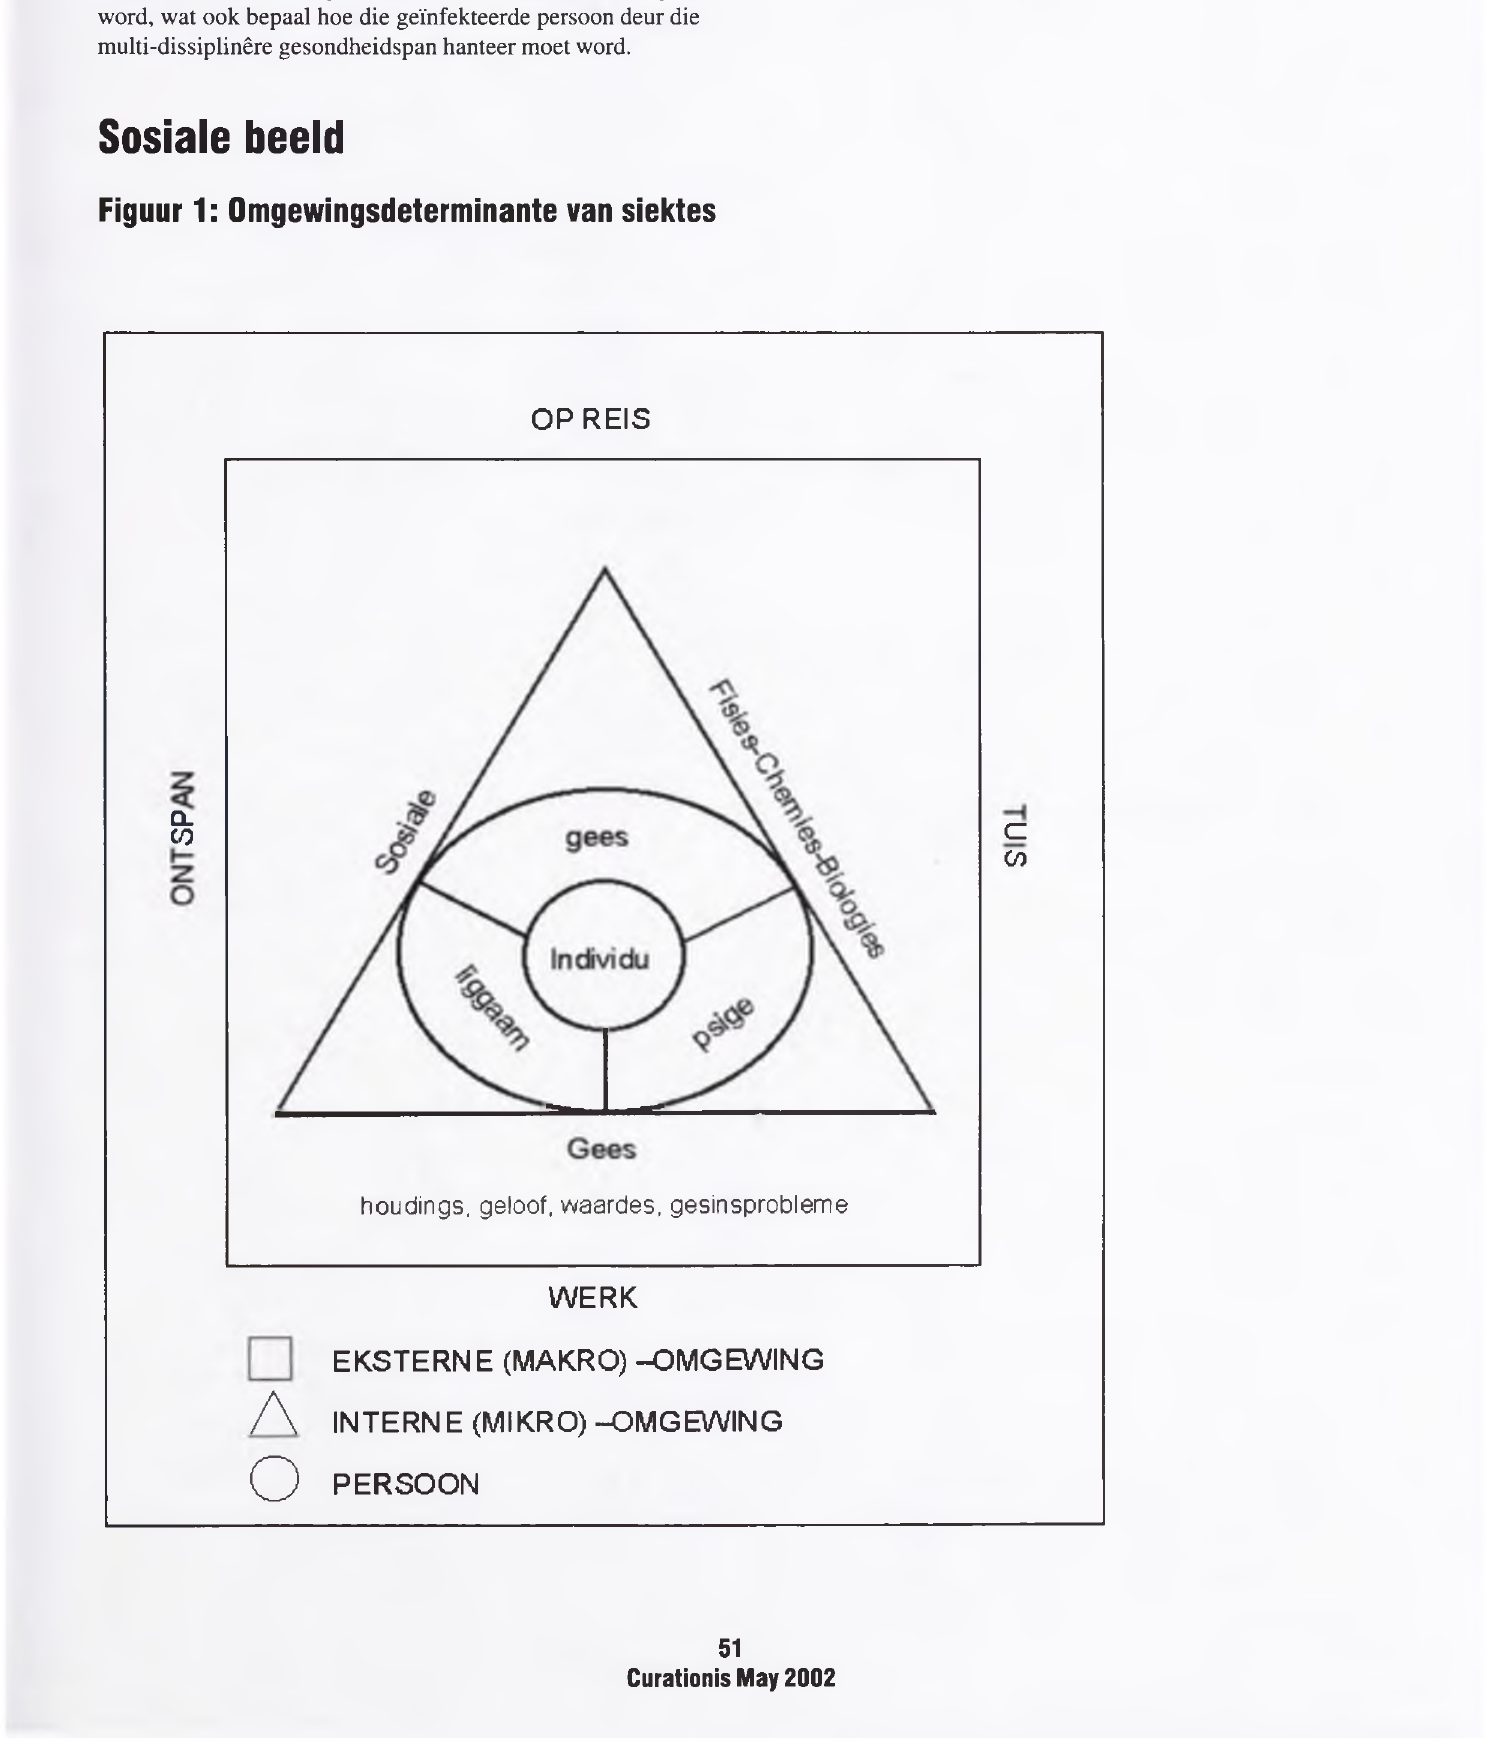
Figuur 1: Omgewingsdeterminante van siektes